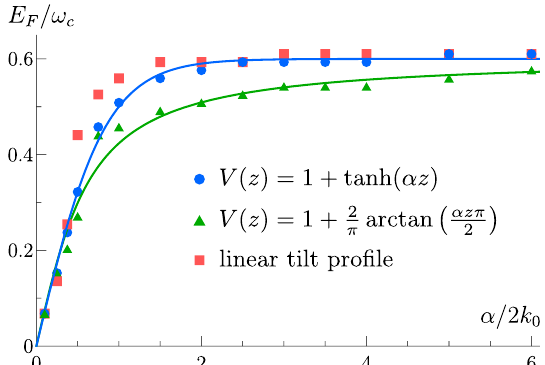
Figure 7: Position of the local maximum in the zero-bias differential conductance for the w mode, as a function of the Fermi energy E 1 α , for different tilt profiles (in units of v and green curves are fits of the data to a tanh b α and 2 a π arctan a ≈ 0.6 and b ≈